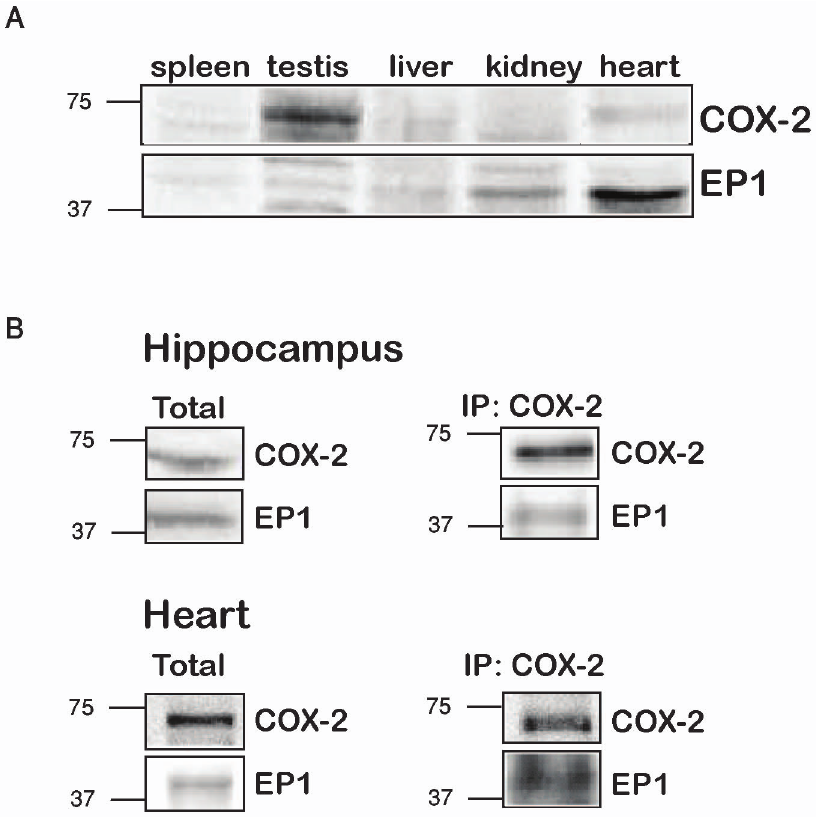
Figure 4. The interaction between COX-2 and EP 1 is observed in rat tissues. A , Rat internal organs were harvested, homogenized and equal amounts of total protein lysates were separated by SDS-PAGE and probed for COX-2 and EP 1 expression. B , COX-2 was immunoprecipitated from hippocampus (upper panel) and heart tissues (lower panel) and probed for COX-2 and EP 1 . Both tissues show the presence of EP 1 in COX-2 precipitates.